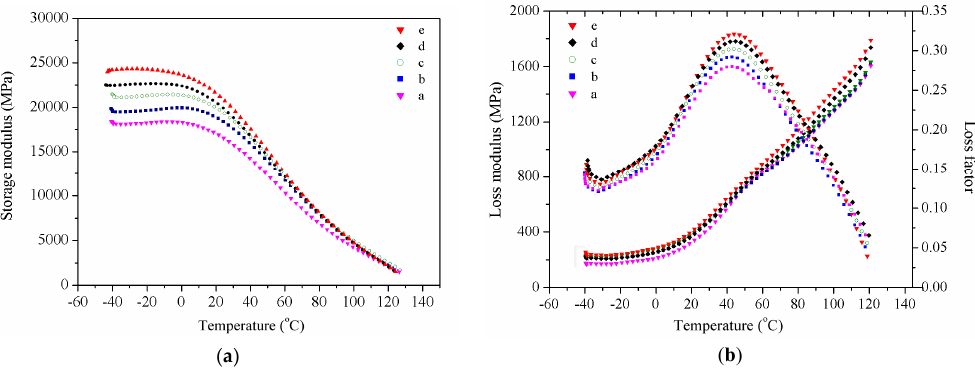
Figure 7. Variation of ( a ) the storage modulus and ( b ) the loss modulus and the loss factor with the steam temperature: a : untreated fibers; b : T = 120 °C, p = 0.2 MPa, t = 5 min; c : T = 160 °C, p = 0.6 MPa, t = 5 min; d : T = 160 °C, p = 0.6 MPa, t = 15 min; and e : T = 170 °C, p = 0.8 MPa, t = 5